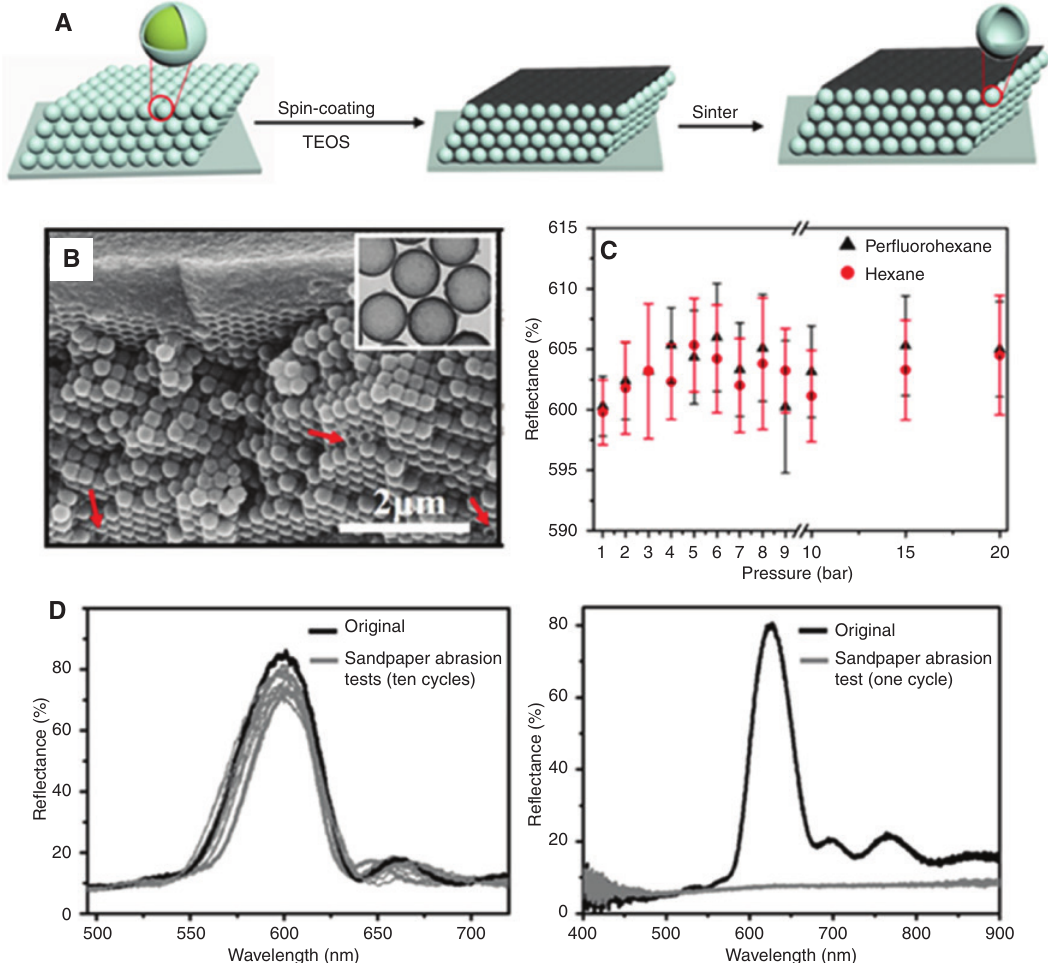
Figure 10: Fabrication of robust sealed CPCs based on hollow spheres as building blocks. (A) Schematic illustration of the fabrication process. (B) The microscope image of the obtained sealed HSCPCs. (C) High-pressure stability of the sealed HSCPCs sample for against low surface tension liquid. (D) The comparison of mechanical strength test of the sealed HSCPCs (left) and traditional solid sphere CPCs (right) by sand paper abrasion. Adapted with permission from ref. [32], COPYRIGHT 2016 WILEY-VCH Verlag GmbH & Co. KGaA,